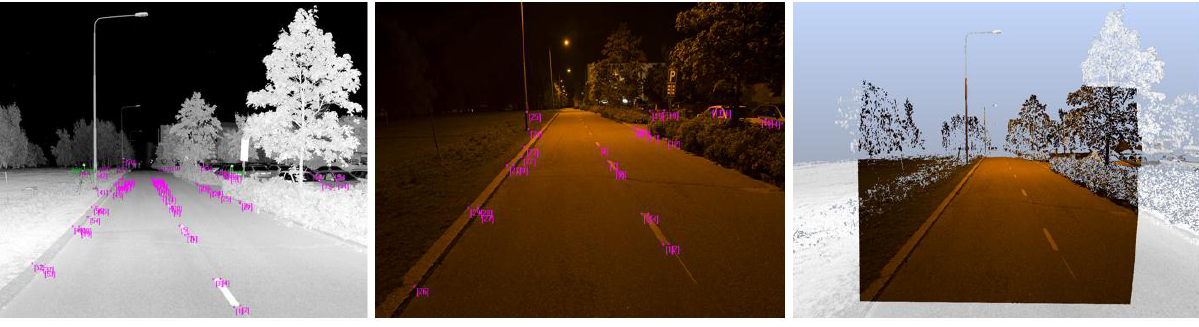
Figure 4. Road features such as paintings and kerbstones were used as corresponding points between a TLS-based intensity image and an RGB image for resolving the relative orientation.